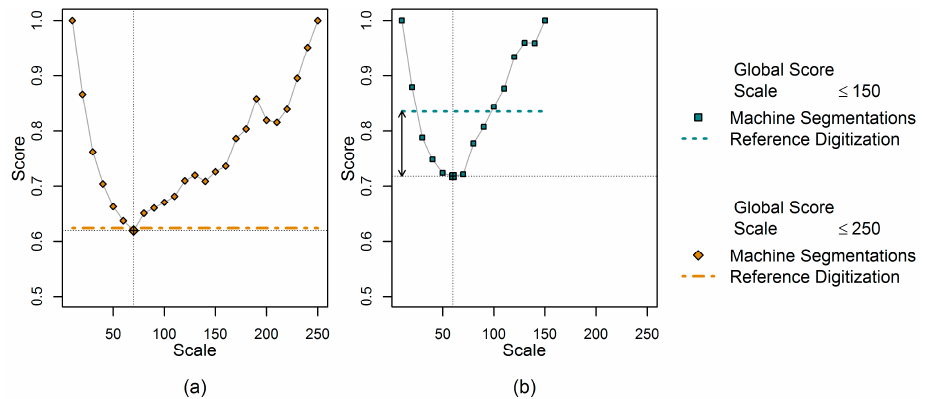
Figure 4. Illustration of problematic usage of GS published by Johnson and Xie [13]. ( a ) Comparing the results of GS for their set of tested segmentations and the score obtained for their manual digitization. ( b ) Results calculated for a (hypothetically) reduced set of segmentations. Changing the set of segmentations causes the optimum to shift slightly and, more remarkably, a worse relative score for their reference digitization is obtained.